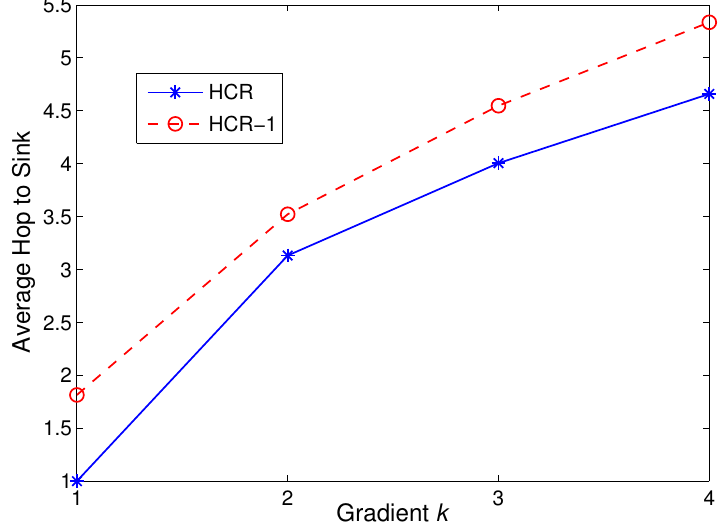
Figure 12. Average hop count comparison in different